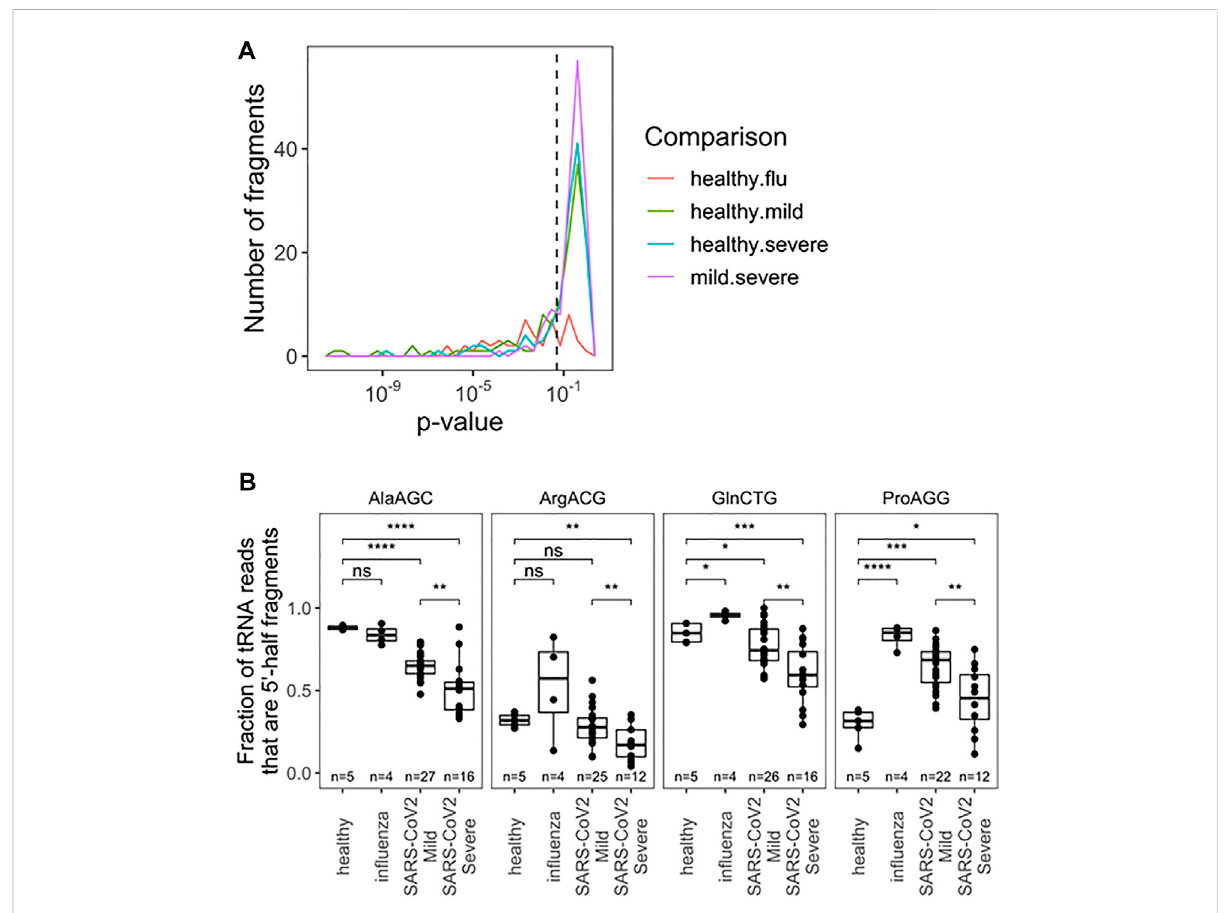
FIGURE 2 Fragmentationpro fi le ofspeci fi ctRNAIsoacceptorfamilies allows for seperation ofRNAobtained fromnasopharyswabscollectedfromSARS- CoV-2 infected individuals who developed mild or severe symptoms. (A) Uncorrected p -Values for pairwise two-sided t-tests indicate several notable differences in fragmentation amoung speci fi c tRNA isoacceptor families. Precise values are indicated in table S2. (B) Fragmentation pro fi es for top anticdon-cleaved tRNAs are hightlighted:tRNA Ala , tRNA Arg (ACG), tRNA pro (AGG), and tRNA GIn (CTG). In addition to distinguising among SARS-CoV-2 patients, fragmentation can provide diagnostic insight which compared to healthy patients. p -values:* < 0.05; ** < 10 − 2 ;*** < 10 − 3